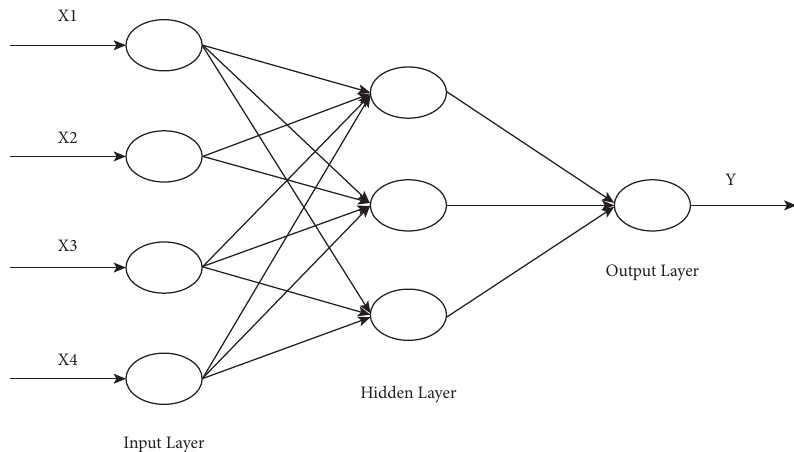
Figure 4: The arrangement of artificial neural network